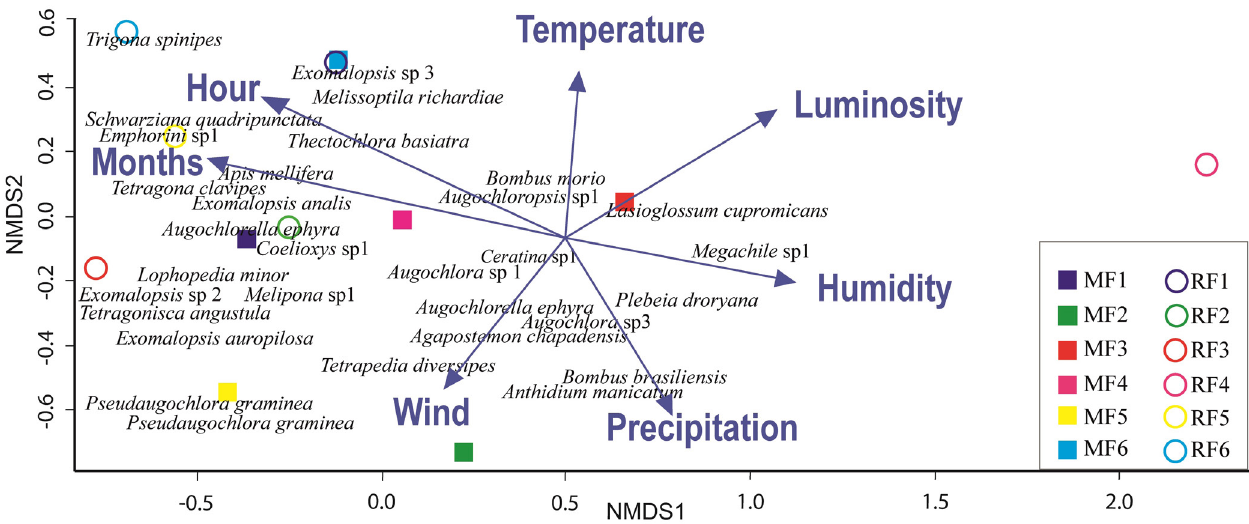
Fig 6 . Non-metric multidimensional scaling (NMDS) of the assemblage of bees by climatic and enviromental conditions (air relative humidity, precipitation, solar intensity, air temperature and wind speed) and temporal conditions (hours and months) in the forest fragments of the Atlantic Forest, Paraná, southern